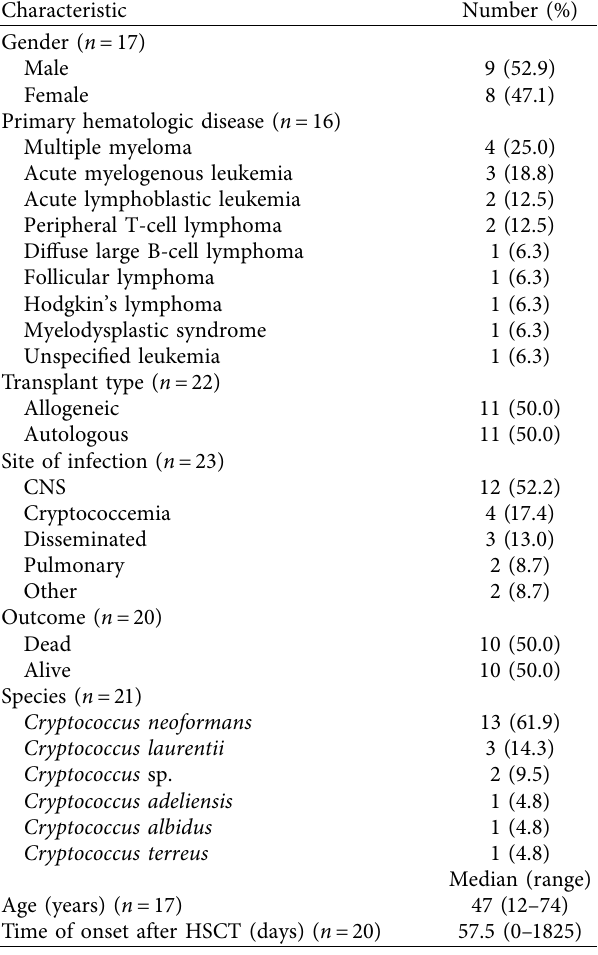
Table 2: Demographic and clinical characteristics of hematopoietic stem cell transplant recipients with cryptococcosis and charac- teristics of the